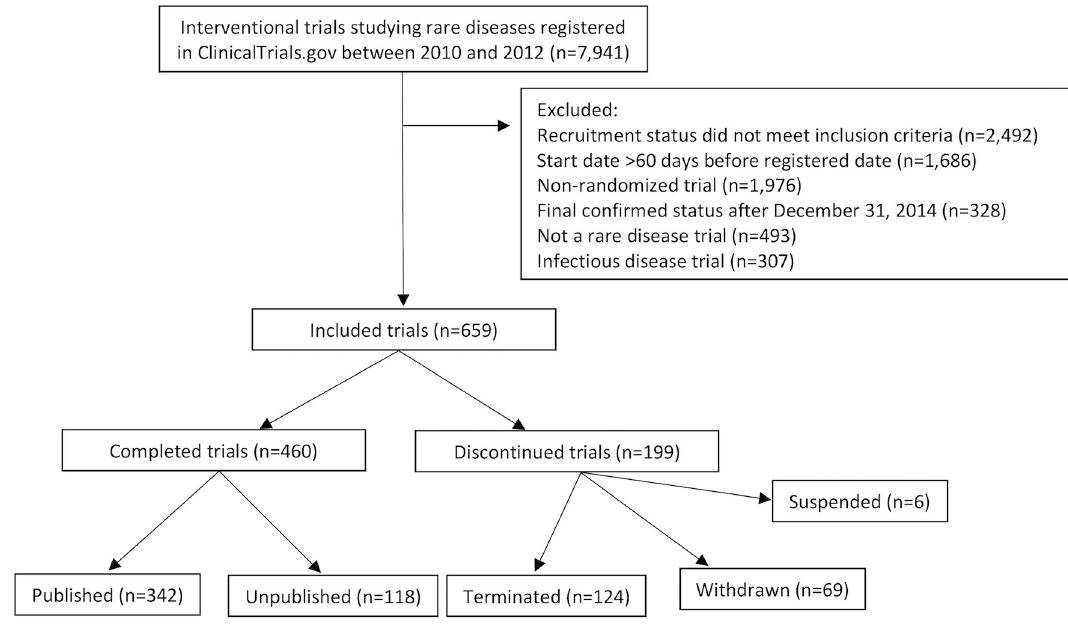
Fig 1. Selection of rare disease trials.